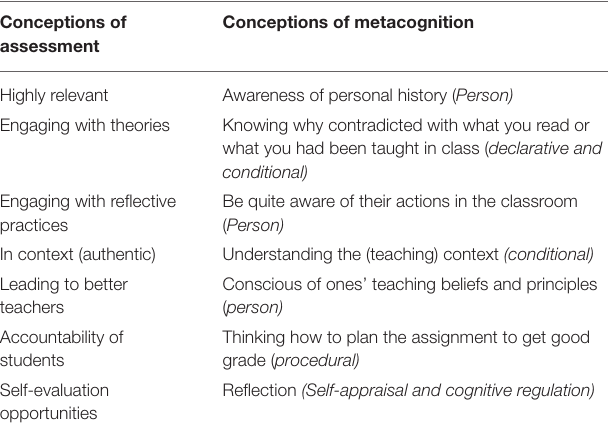
TABLE 6 | Megan’s conceptions of assessment and